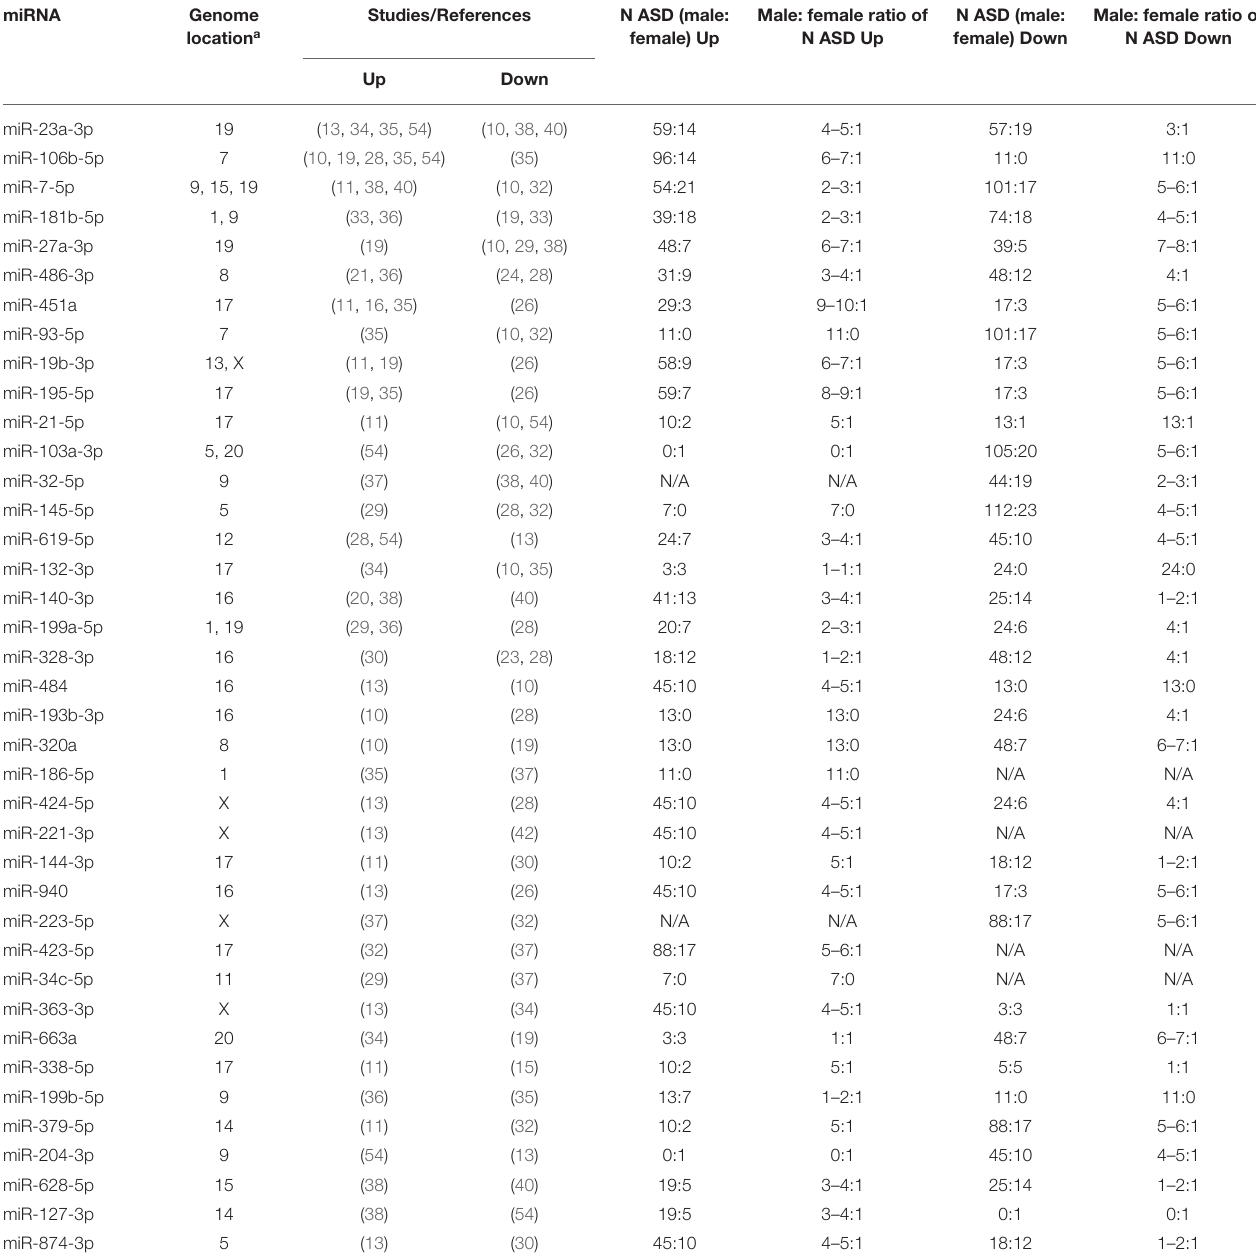
TABLE 2 | Inconsistently dysregulated miRNAs reported in at least two expression profiling studies. miRNA Genome location